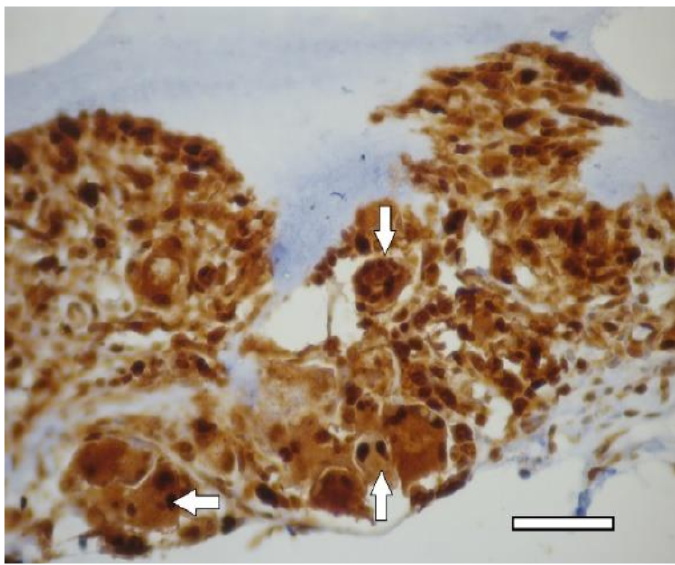
Figure 7. 1st group (dECM only), 1 week. PCNA-positive multinucleated cells resorb around the perimeter of the scaffold in the connective tissue capsule (arrows). Immunohistochemical staining for PCNA, objective lens × 40, scale bar—50 µ